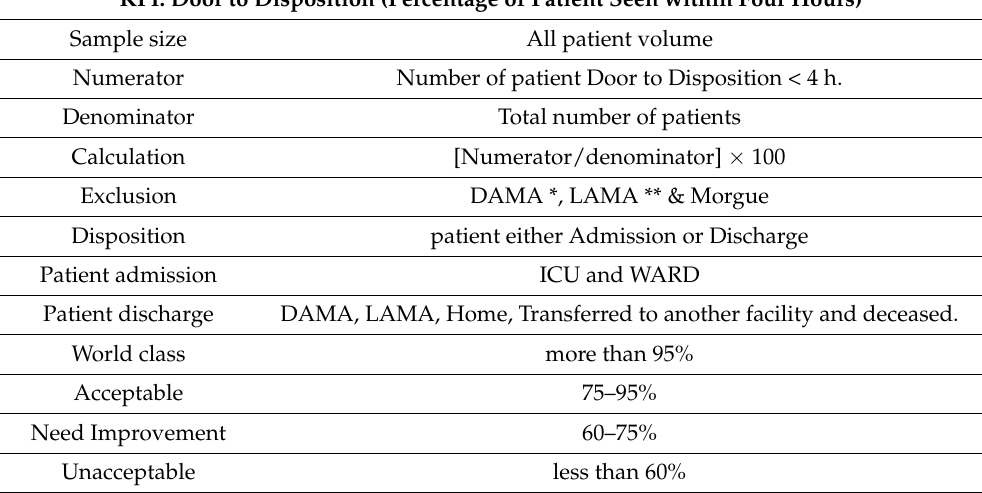
Table 1. Data collection/Measurement in Emergency